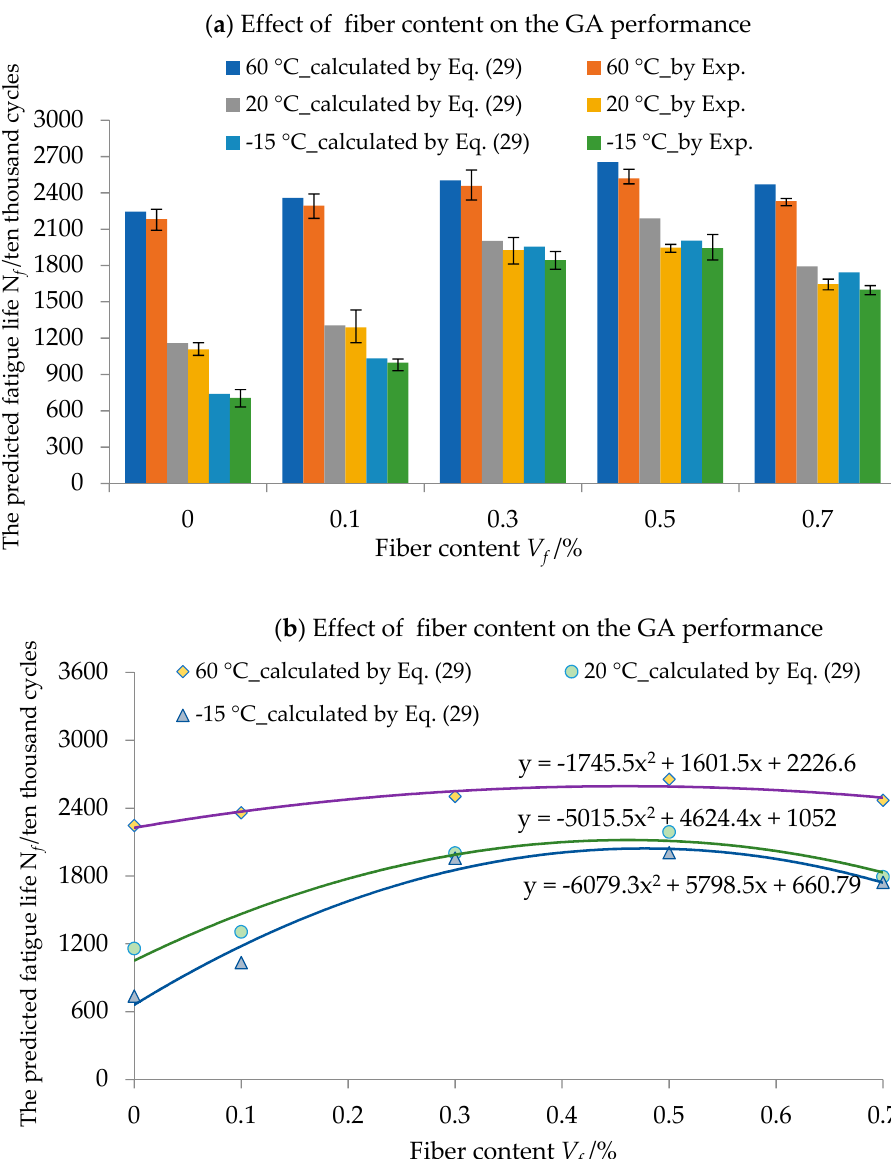
Figure 6. Comparison between the predicted and measured fatigue life under different temperatures and fiber contents (tested under standard axle load, BZZ-100) (unit: 10,000 cycles). ( a ) Effect of fiber length on the GA performance (the theoretically predicted value and test results); ( b ) Effect of fiber length on the GA performance.